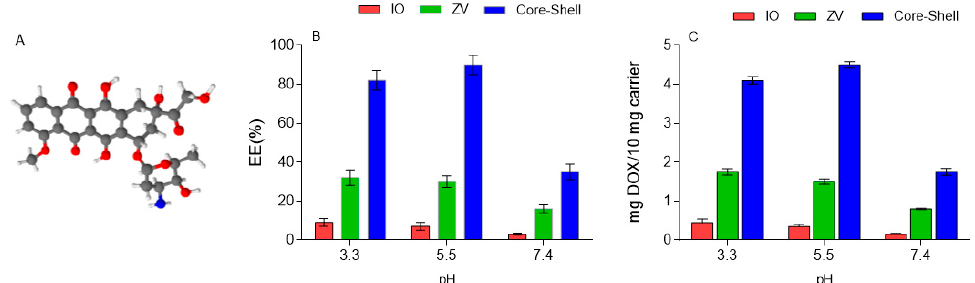
Figure 4. Effect of surface modification and polymer coating on the EE of DOX under different pH levels ( A ) Three-dimensional structure of DOX. ( B ) Evaluation of the effect of pH on the encapsulation efficiency (EE) at a 1mg/mL drug concentration. ( C ) The relationship between DOX concentration and EE at pH 5.5. For encapsulation, DOX concentration is 1 mg/mL (volume of 5 mL), and the weight ratio between DOX and carrier is 1:10. Values are reported as averages, and error bars represent the SD (n = 3).